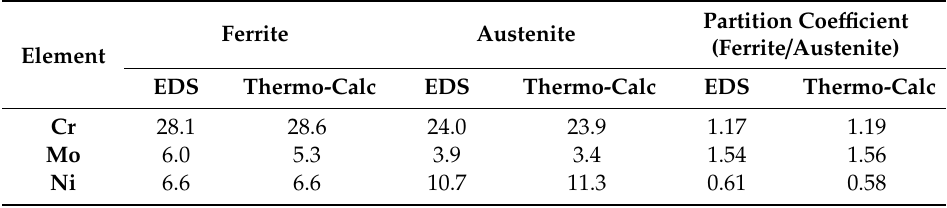
Table 3. (EDS) and calculated (Thermo-Calc) compositions of ferrite and austenite after solution treatment at 1100 °C and water quenching (wt.%).